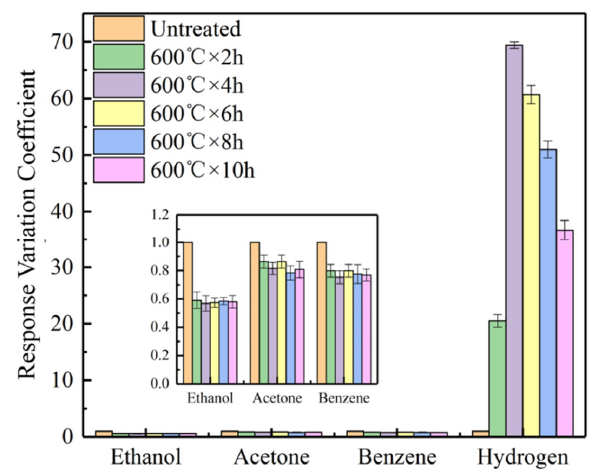
Figure 13. The response variation coefficients of the sensors CVD-treated at 600  C with exposure to 1000 ppm hydrogen at 200  C. 1000 ppm hydrogen at 200 ◦